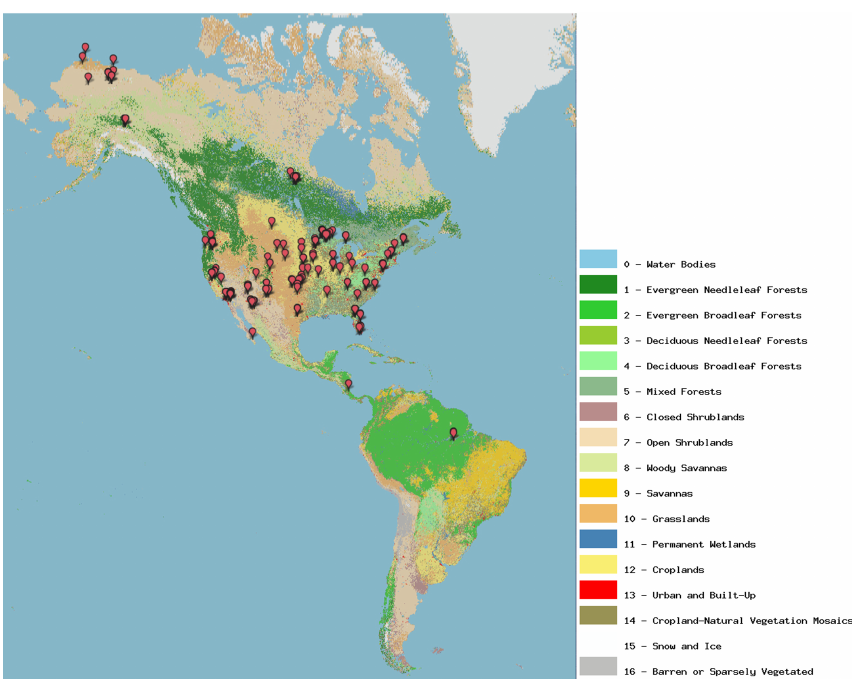
Fig. 1. Geographic distribution of registered flux sites in the AmeriFlux network as of January 2013 superimposed on a map depicting ecosystem representations from the International Geosphere-Biosphere Programme (IGBP).